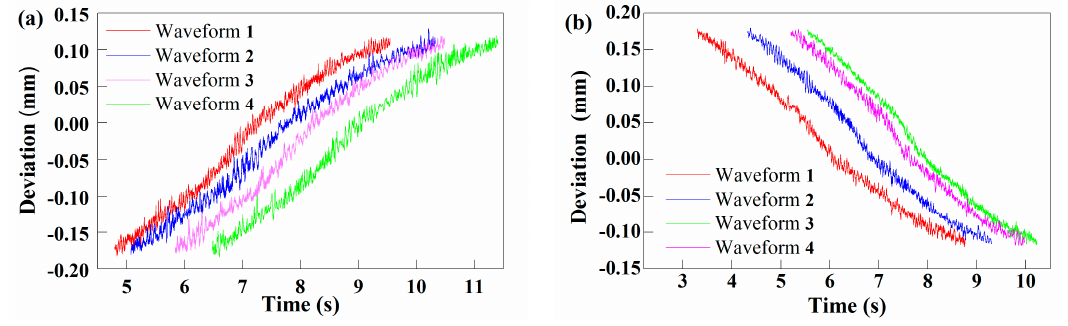
Figure 18. Combined projection waveforms. ( a ) PB is the measured surface ( b ) PA is the measured surface.